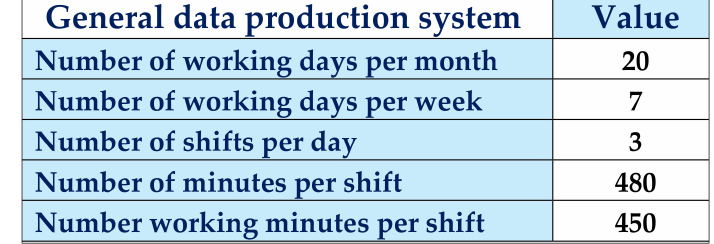
Figure 14. General data of the production system “plastic injection”.